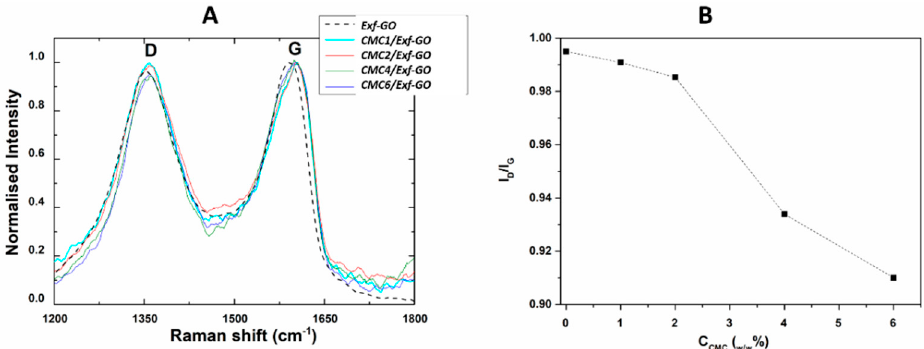
Figure 2. ( A ) Raman spectra of CMCx / Exf -GO nanocomposites; ( B ) I D / I G ratio for CMC-based nanocomposites as a function of CMC%.